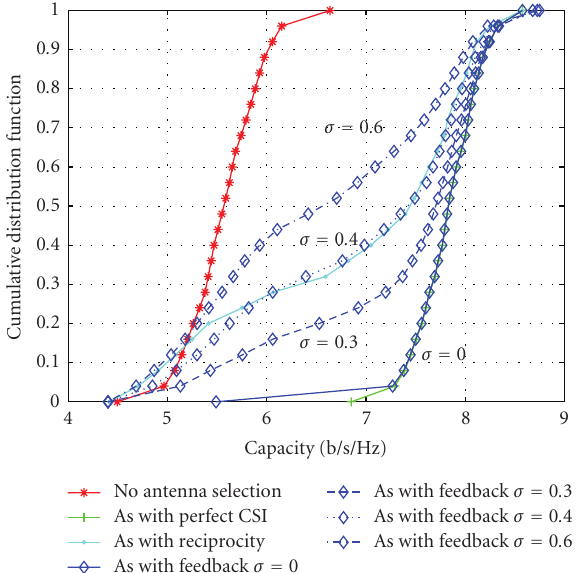
Figure 11: The cumulative distribution function of capacity with the presence of feedback error at Location